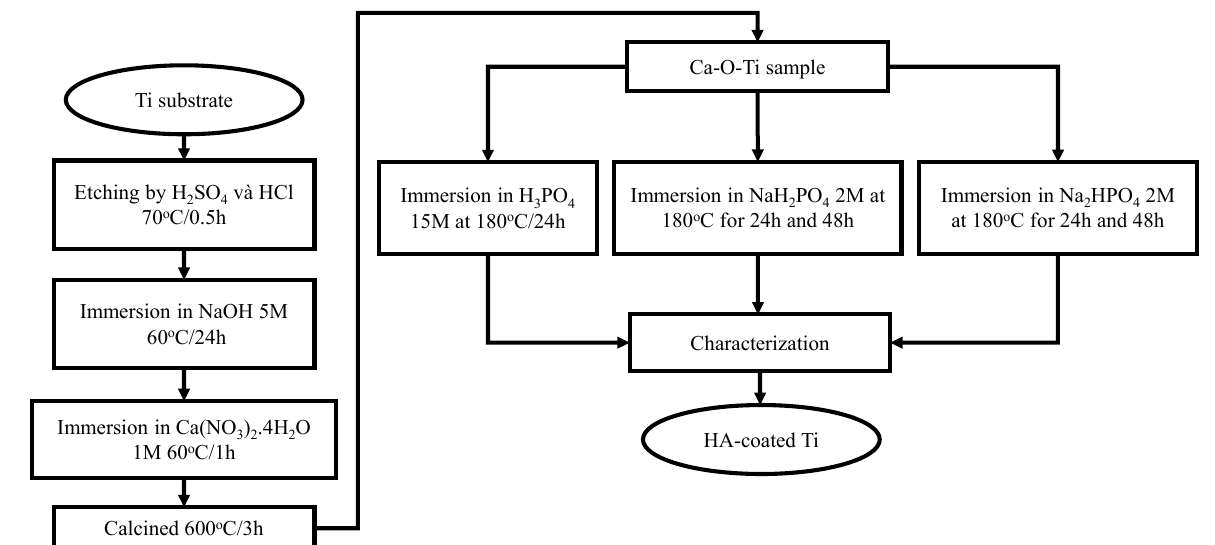
Figure 1. Flowchart of preparation HA-coated